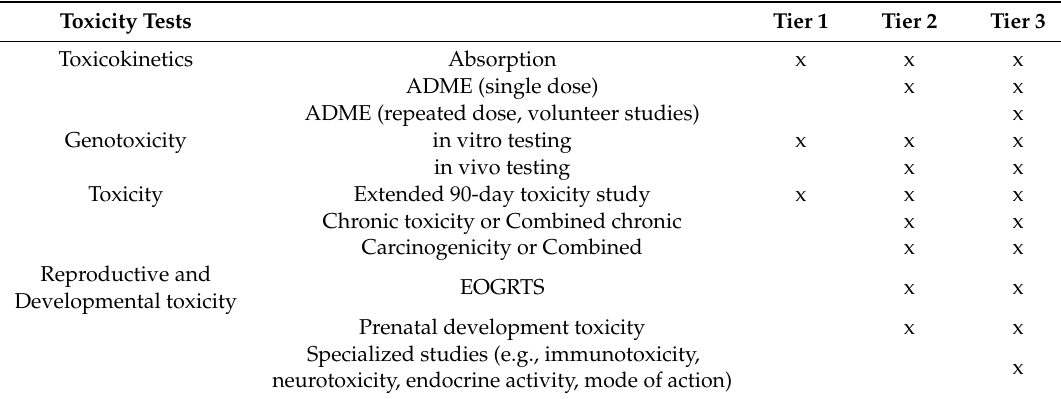
Table 1. Toxicity tests requested by the European Food Safety Authority for safety evaluations of food